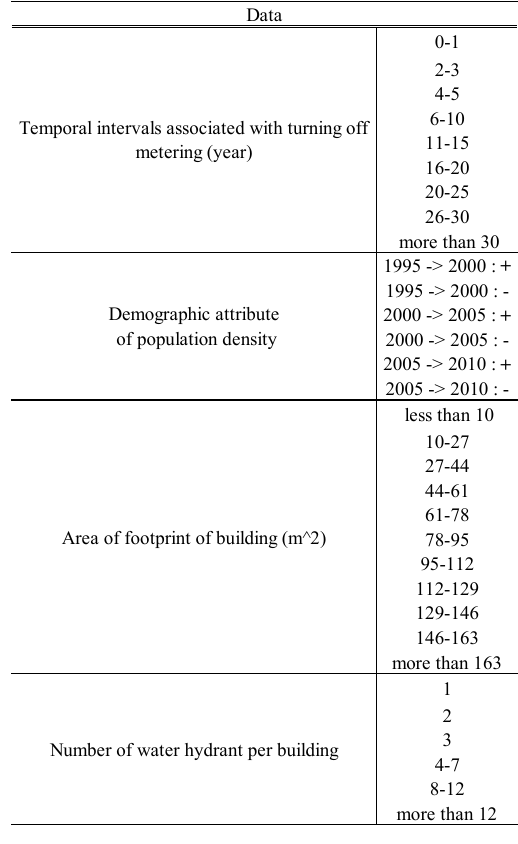
Table 1. Attributes of geographical data we